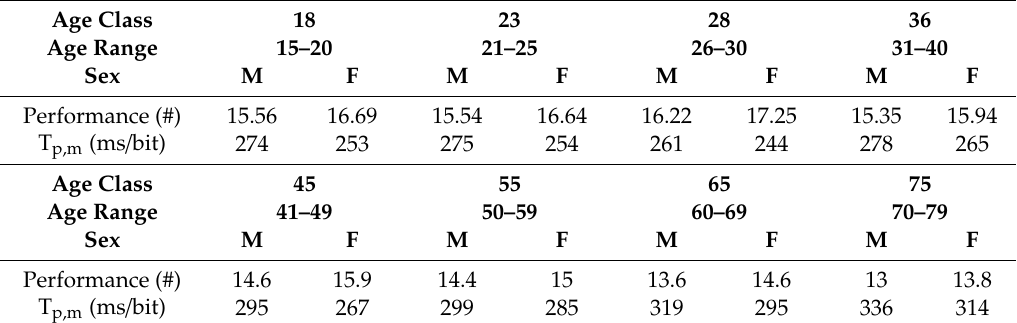
Table 4. Performances (average number of placed pegs (#)) and motor processing times (T p,m ) of